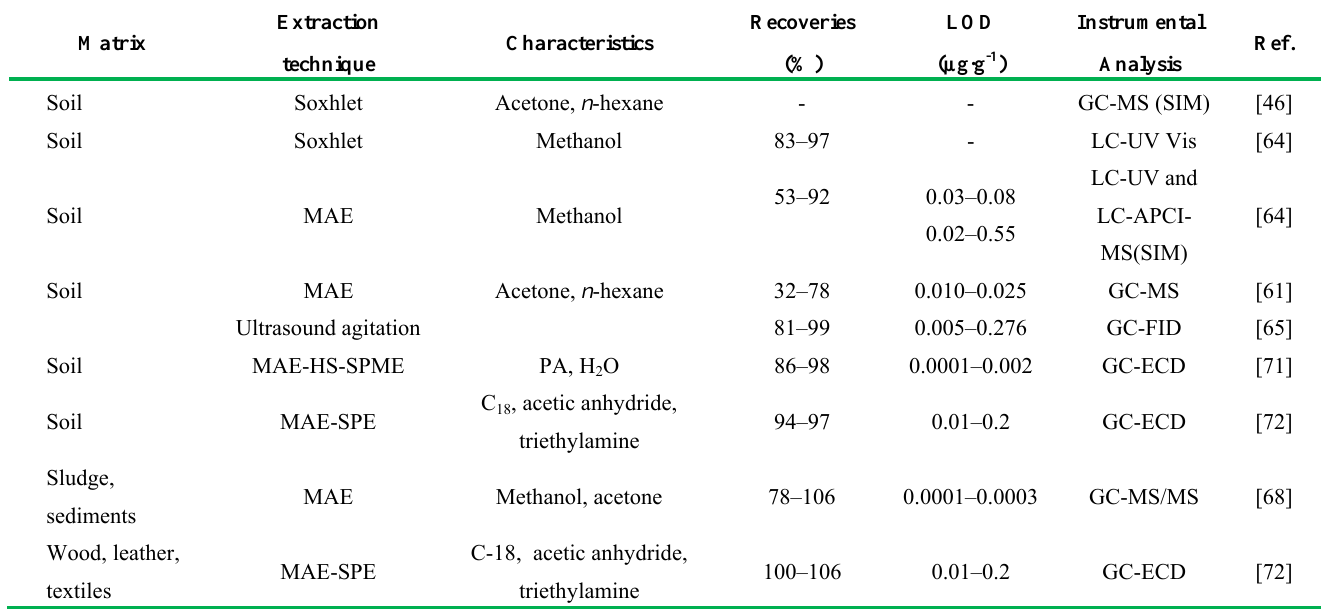
Table 2 . Methods for the determination of phenolic compounds in solid samples using organic